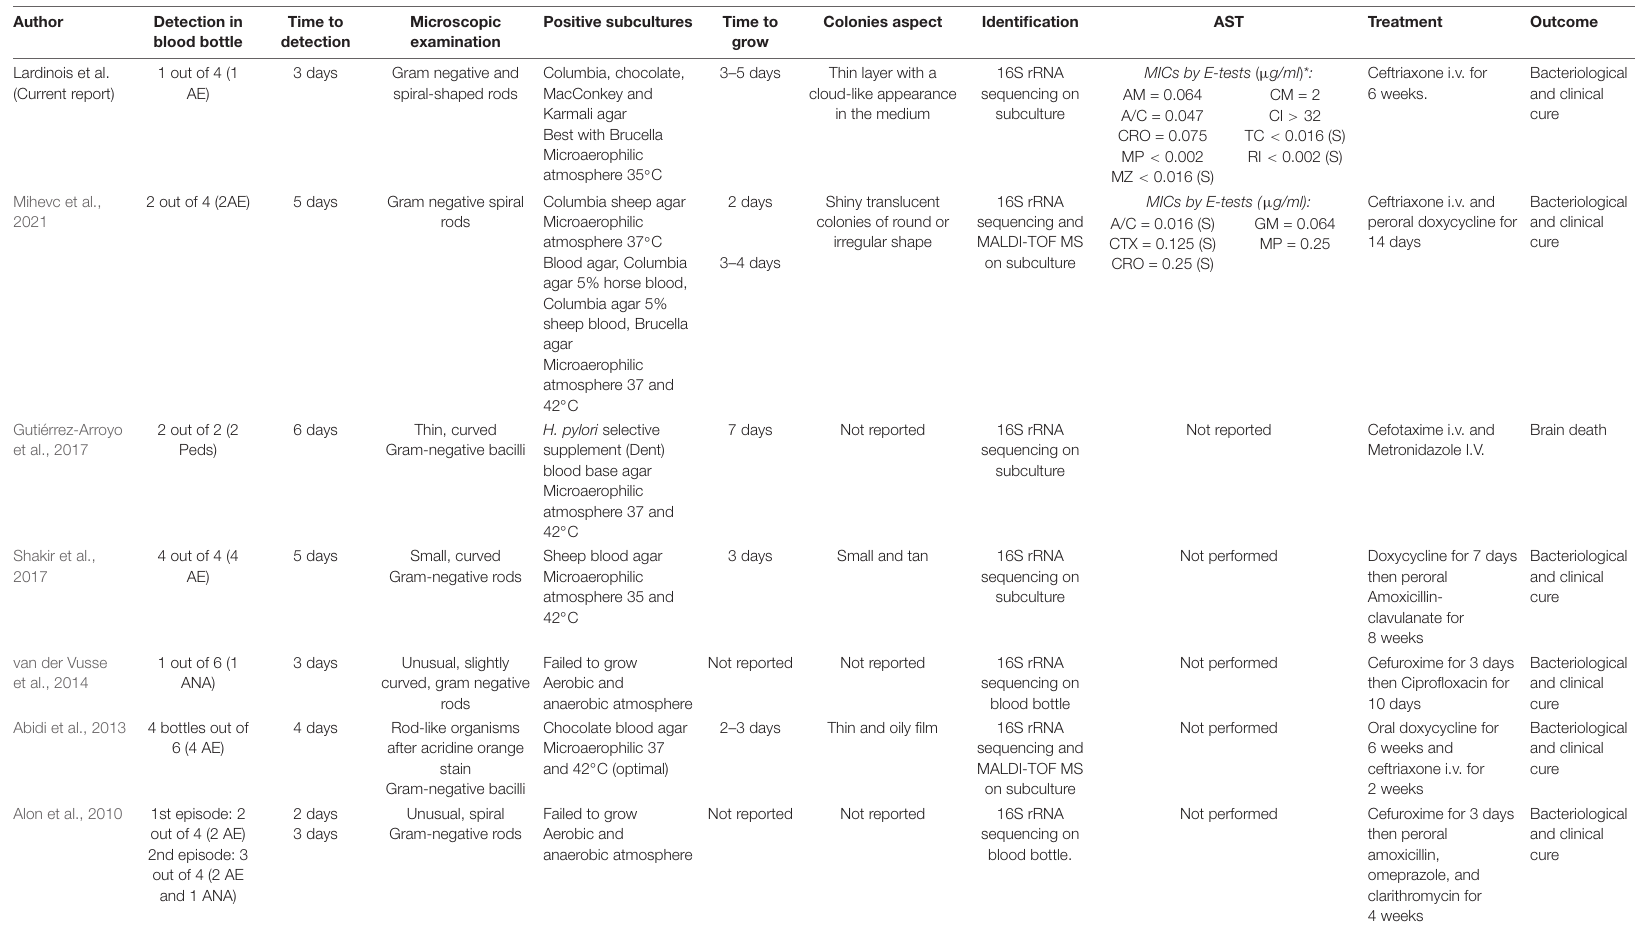
TABLE 1 | Previous and current microbiological investigations of H. canis isolated from blood cultures.